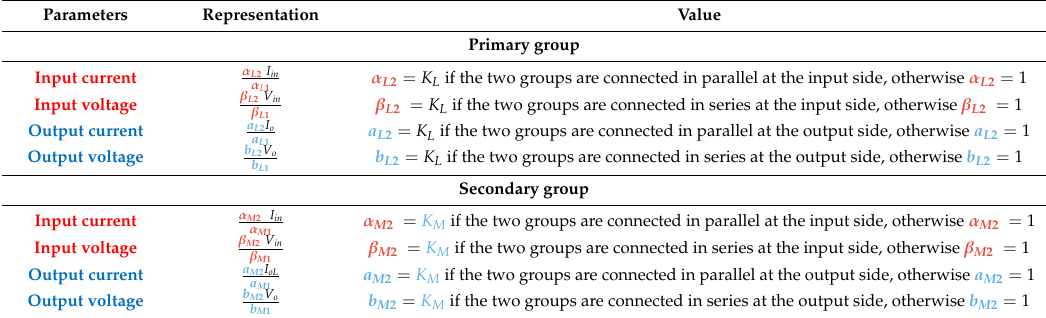
Table 1. Individual module system parameters representation in terms of the overall system ratings.